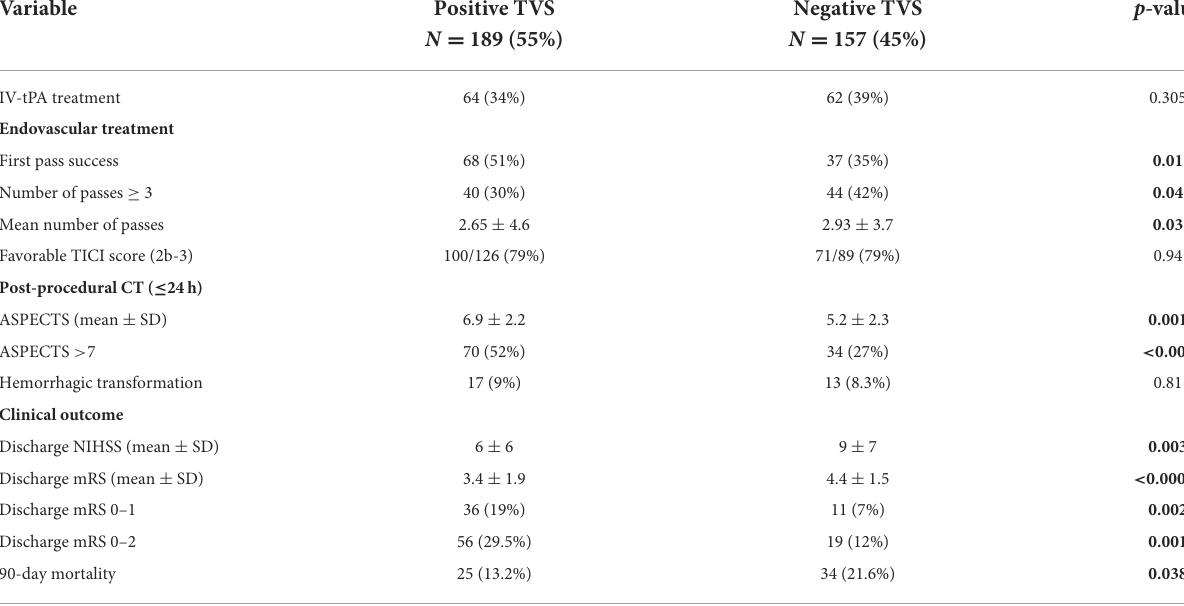
TABLE 3 Recanalization procedures information and clinical